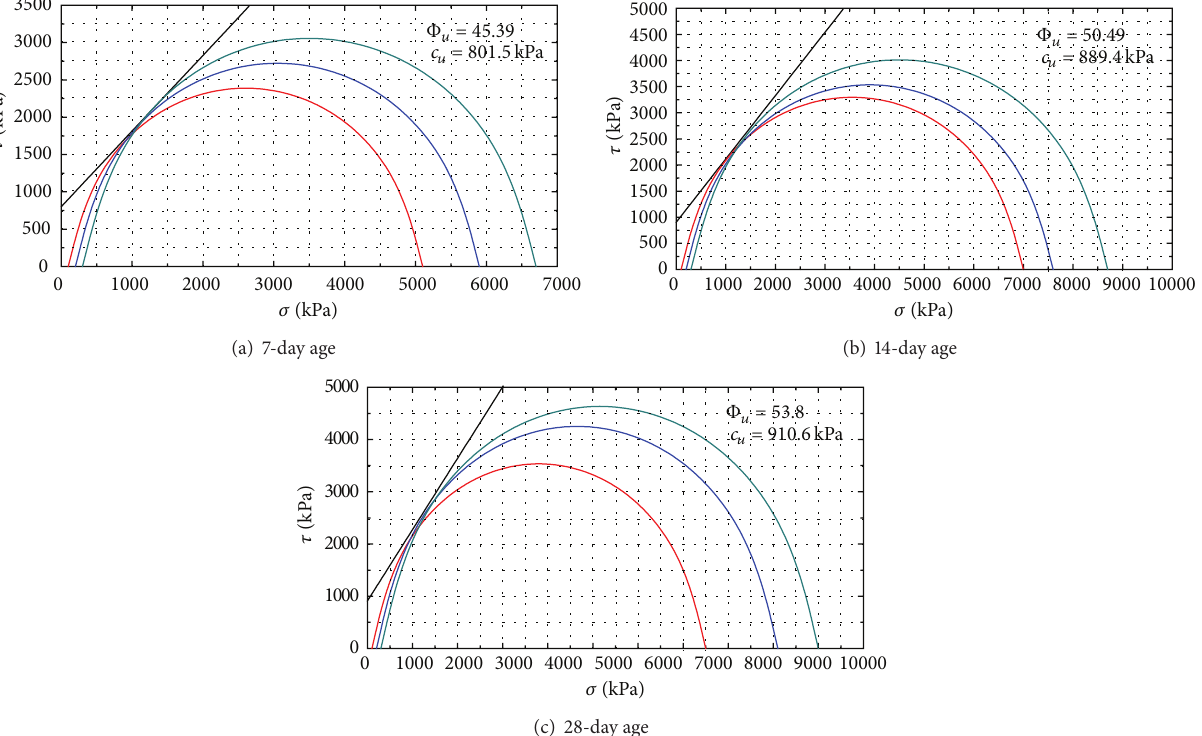
Figure 9: Polypropylene fiber content 1.0% unconsolidated undrained shear strength